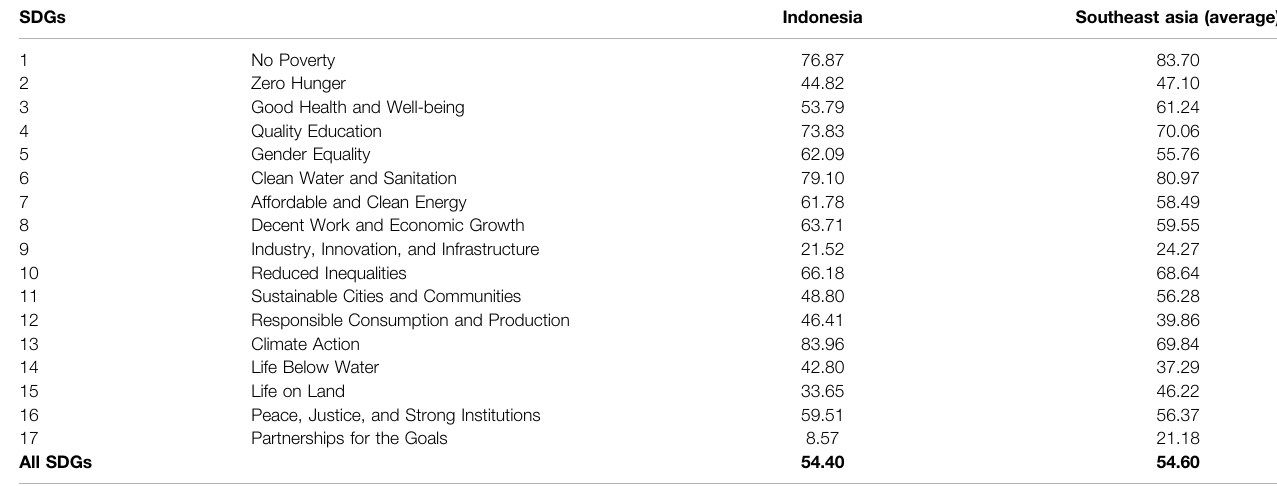
TABLE 1 | Score of SDGs of Indonesia in